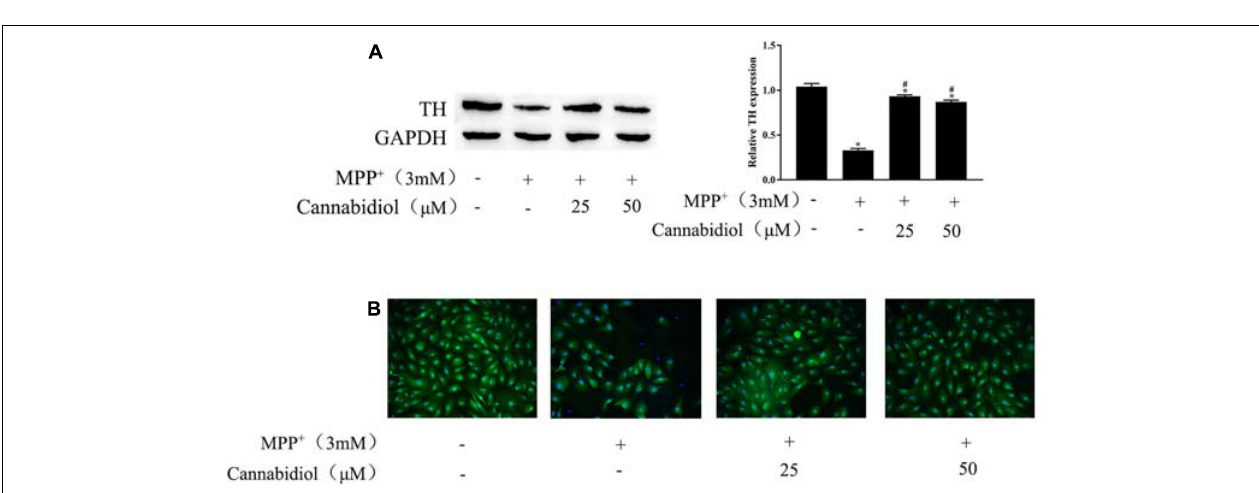
FIGURE 2 | Cannabidiol protected SH-SY5Y cells against MPP + -induced Loss of Tyrosine Hydroxylase (TH) expression. (A) The expression of TH in SH-SY5Y cells were measured by western blotting; (B) The expression of TH in SH-SY5Y cells were measured by Immunofluorescence staining (200 × ); * p < 0.05, compared with control group, # p < 0.05 compared with MPP +